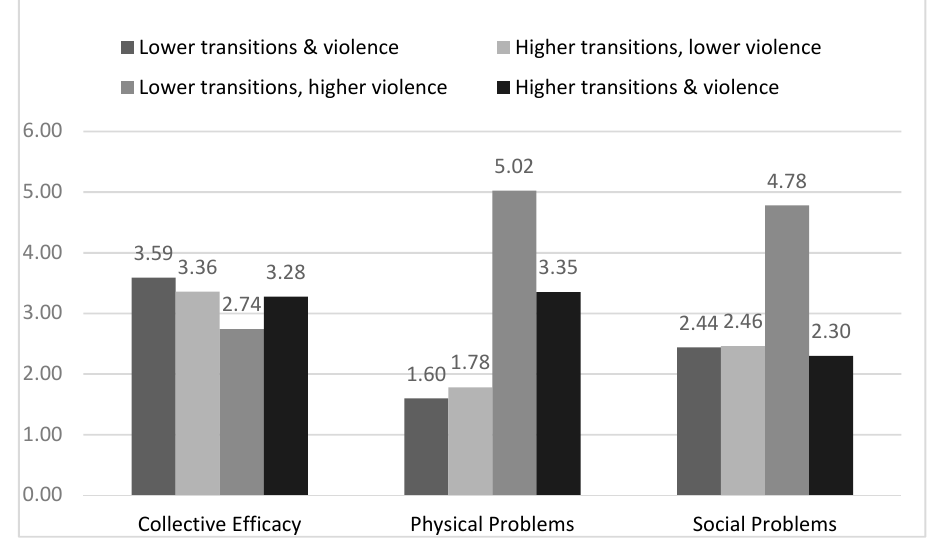
Figure 2. High / low neighborhood transitions and violence: mean neighborhood collective e ffi cacy and Figure 2. High/low neighborhood transitions and violence: mean neighborhood collective efficacy physical and social and physical and social problems.